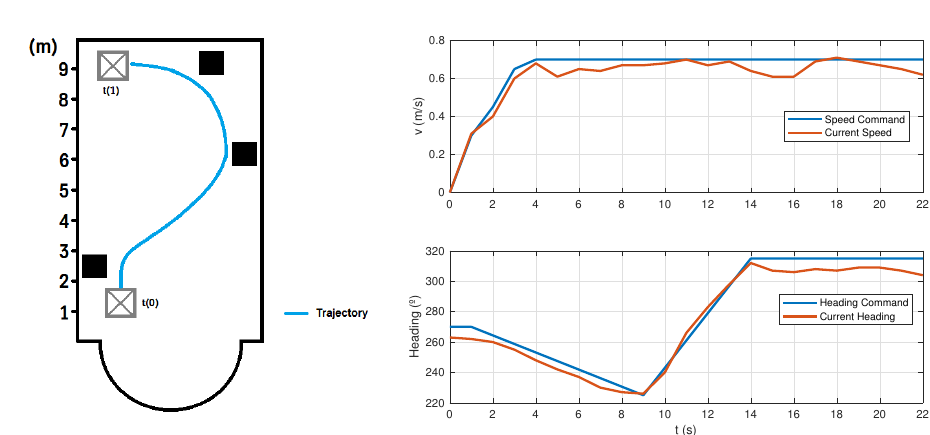
Figure 14. Autonomous test results. Position of the Strider V1.0 ( Left ) and current and reference speed and heading values during test ( Right ).